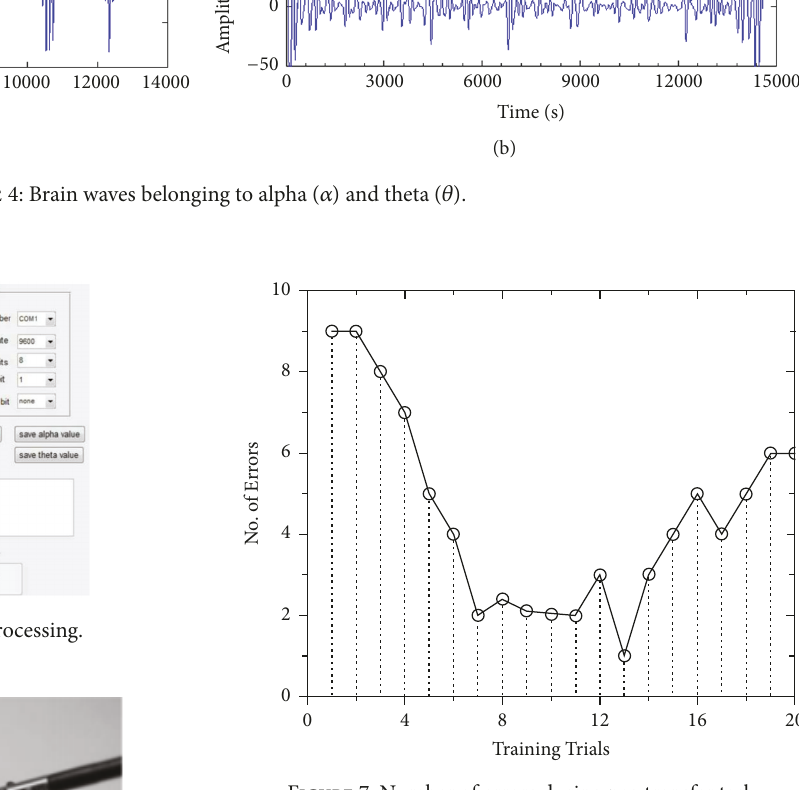
Figure 7: Number of errors during peg transfer